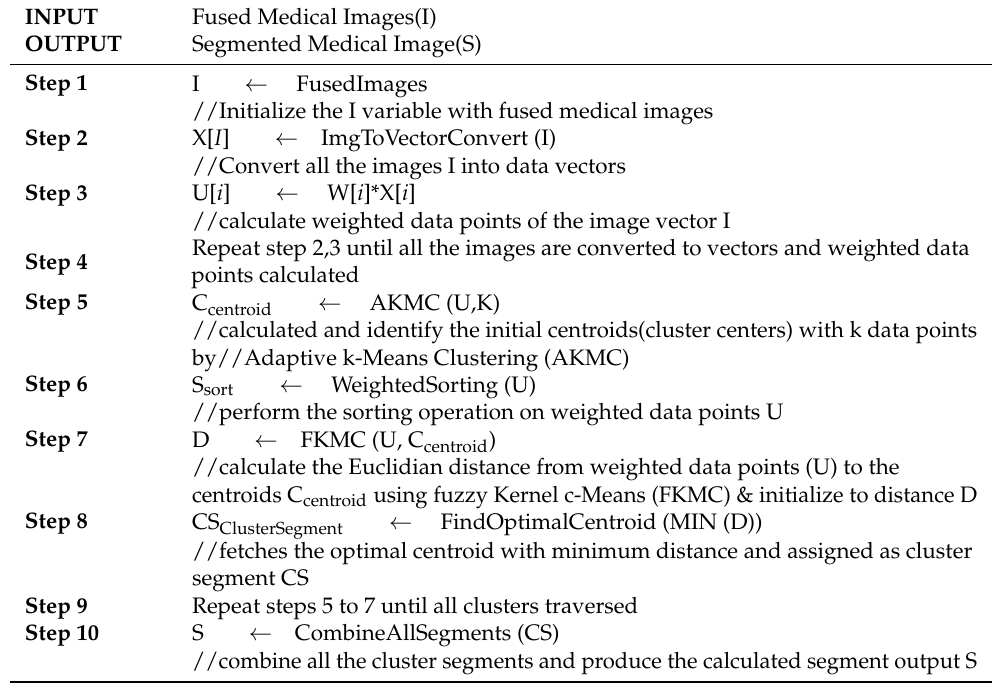
Table 5. Proposed hybrid fuzzy segmentation